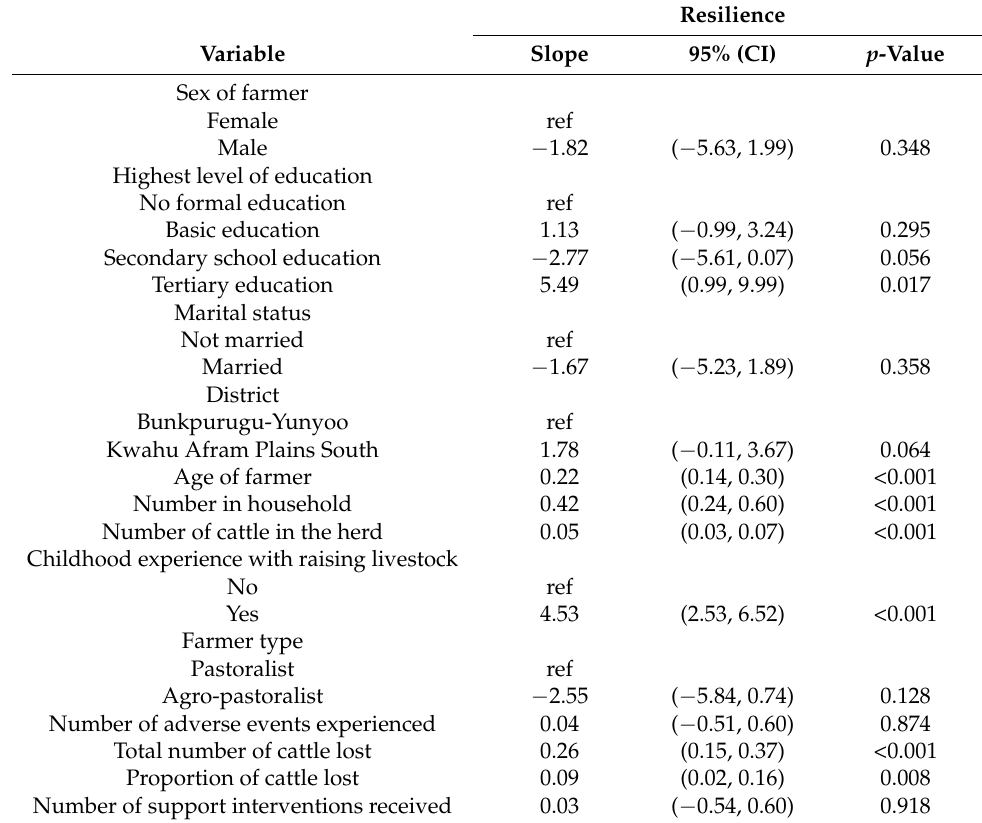
Table 3. Univariable analysis of resilience levels and farmer